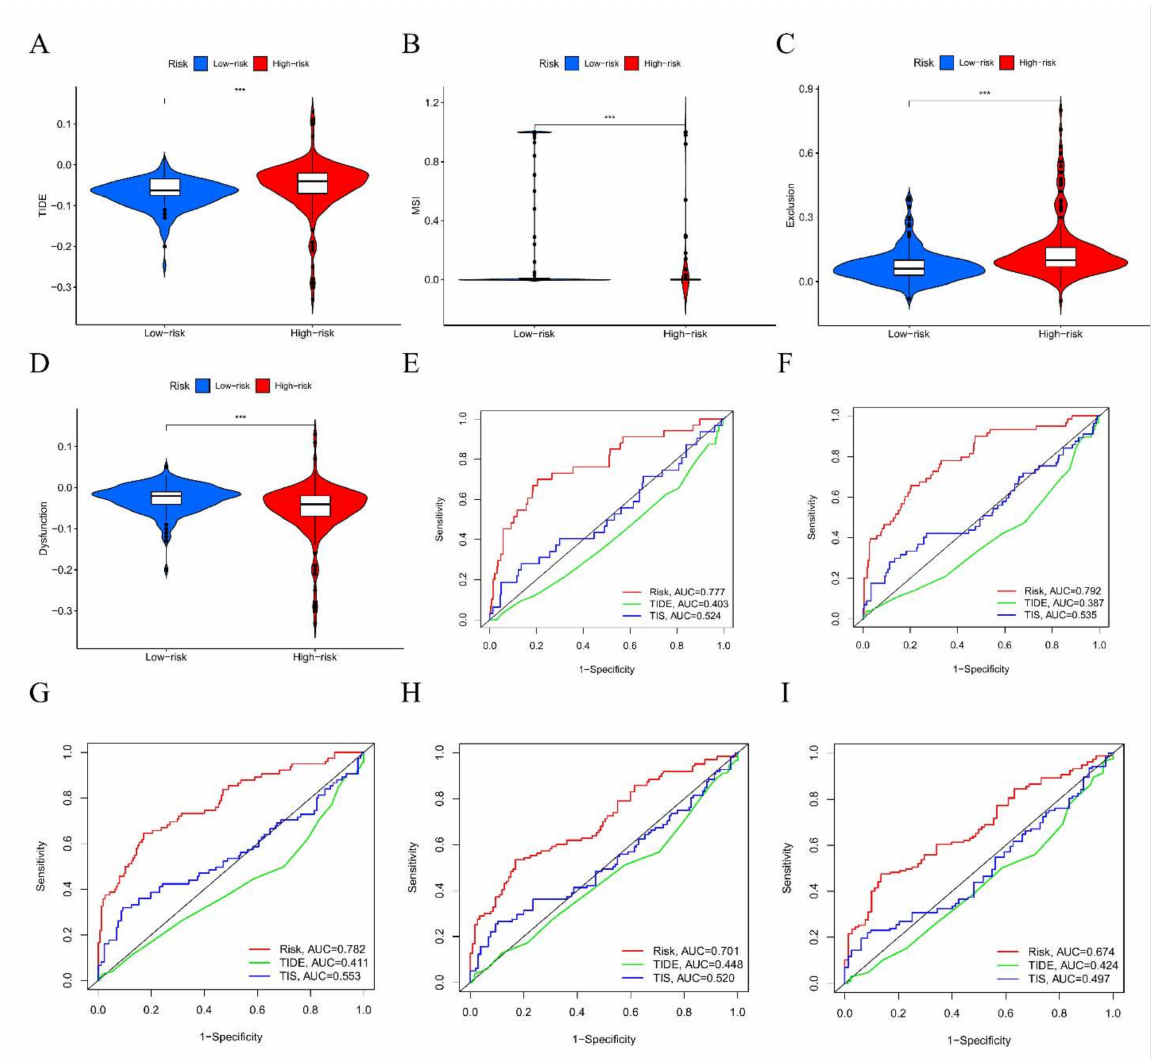
Figure 8. The benefit of ICI therapy in different DRGPI-based risk subgroups. TIDE ( A ), MSI ( B ), T cell exclusion ( C ), and dysfunction score ( D ) in different DRGPI subgroups. The scores between the two DRGPI subgroups were significantly different from TCGA (*** p < 0.001). ( E – I ) ROC analysis was used to verify the prognostic value of DRGPI in the immunotherapy response of ICI; the results indicated that the AUC index of DRGPI was higher than that of TIDE and TIS at 6/12/18/24/36 months of